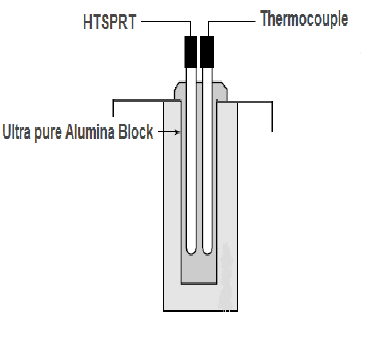
Fig. 1. Alumina block used for calibration of